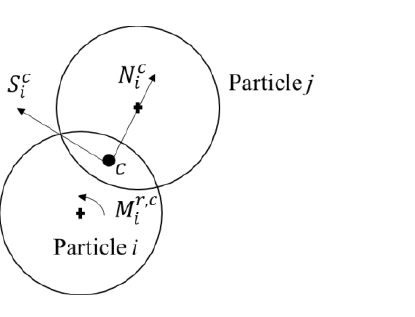
Figure 1. Contact forces generated acting on the i th particle at contact point c .